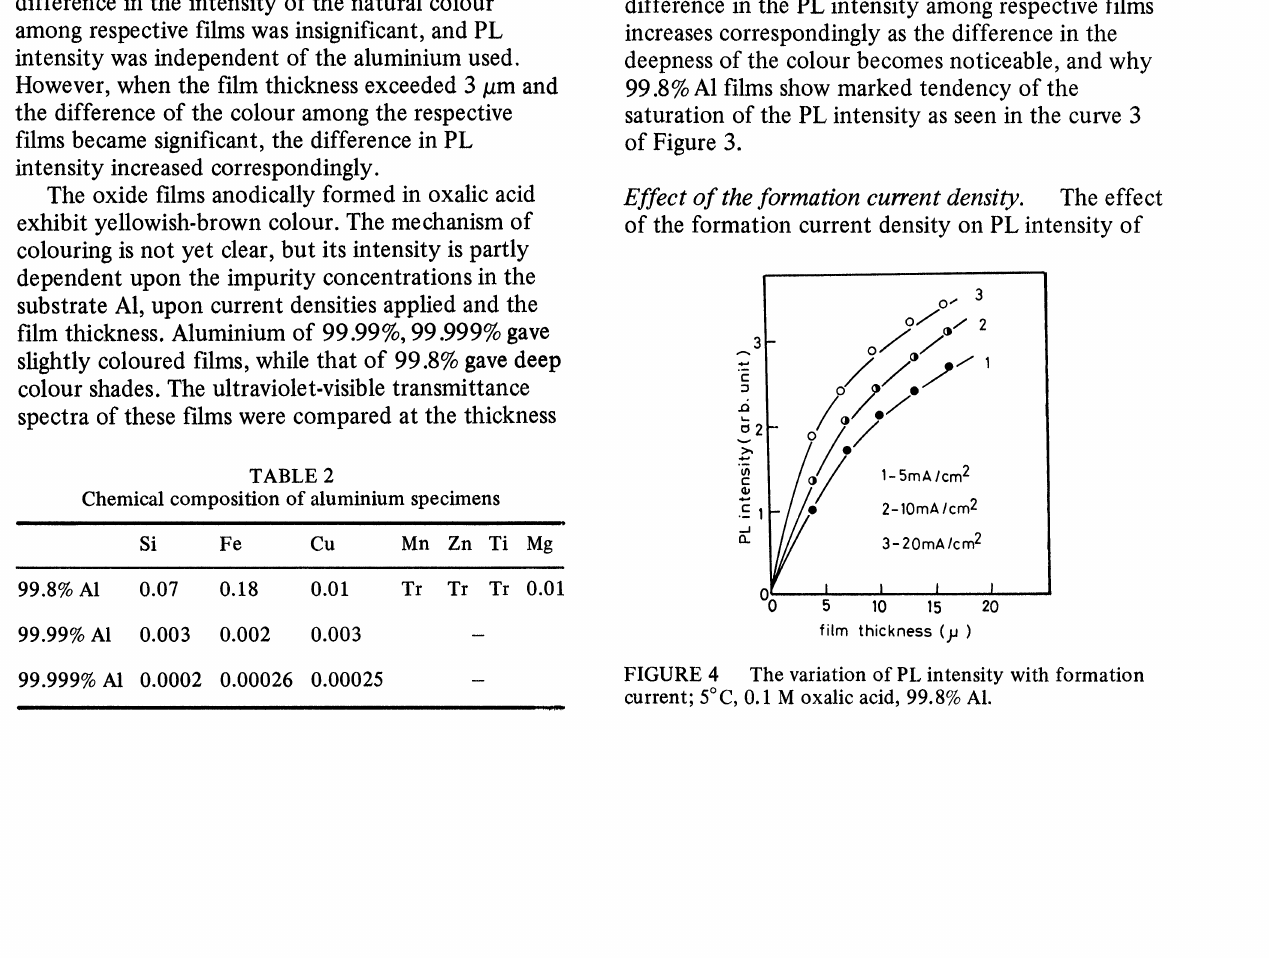
The variation of PL intensity of anodic oxide films formed on A1 of different purity; 50, 0.1 M oxalic acid, 20 mA/cm:.